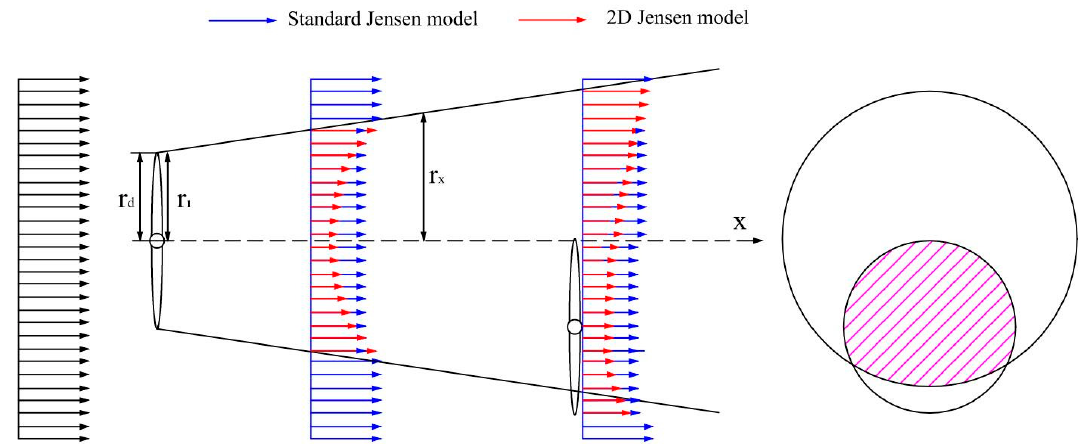
Figure 1. Schematic diagram of wake velocity for multiple wind turbines.